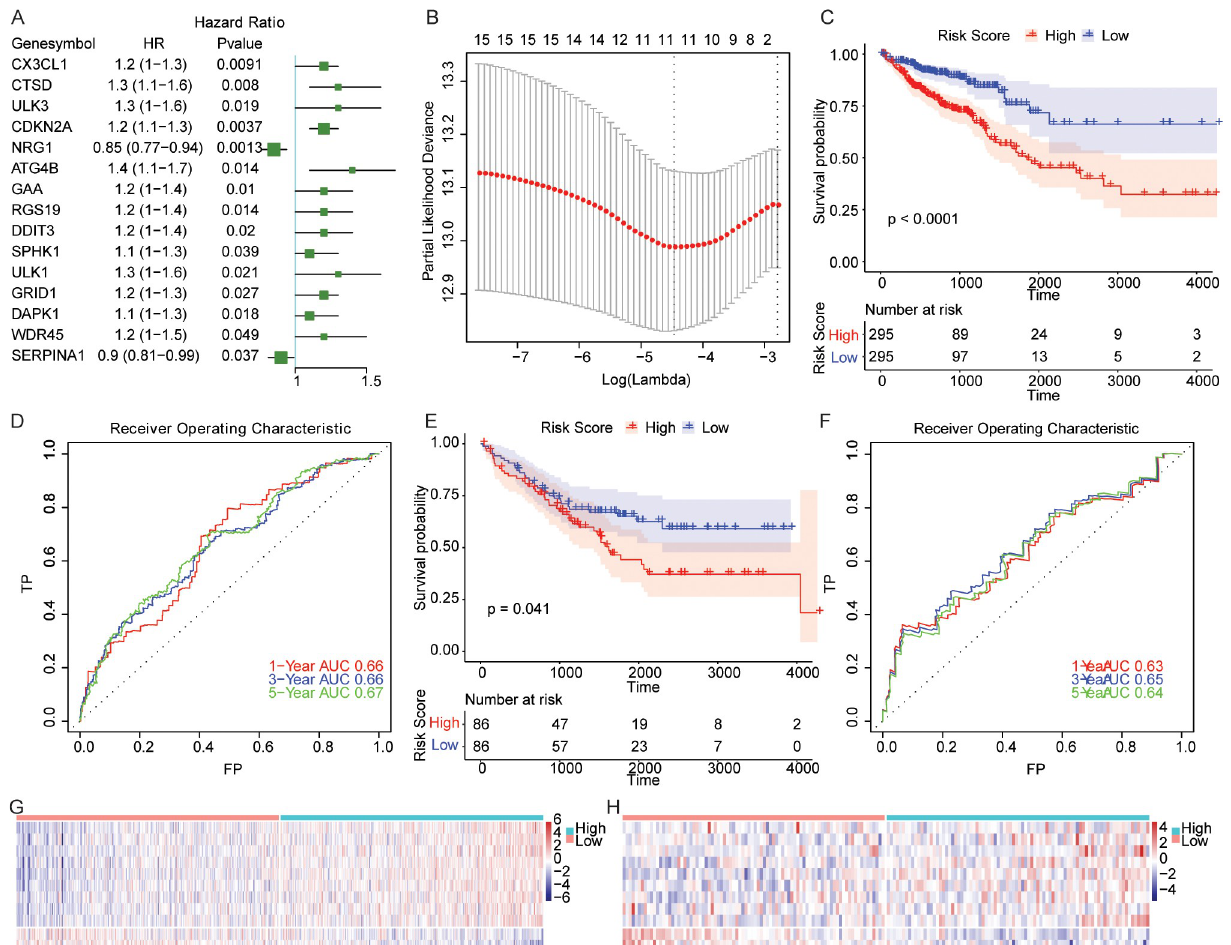
Fig 1. Construction of predictive model for CRC prognosis. (A) Univariate cox regression analysis of the 15 genes that were related to the overall survival (OS) of patients with CRC. HR: hazard ratio. (B) Determination of the lambda value in LASSO regression model. The lambda value which corresponded to the minimum value of Partial Likelihood Deviance was considered as the optimal one. (C) Survival curves of CRC patients in TCGA dataset. P value that calculated using log-rank test was provided. (D) Time-dependent ROC curve for the patients in TCGA dataset. TP: True Positive; FP: False Positive. (E) Survival curve of CRC patients in GEO dataset. (F) Time-dependent ROC curve for the patients in GEO dataset. TP: True Positive; FP: False Positive. (G-H) Heatmaps showing the differential expressions of CX3CL1 , ULK3 , CDKN2A , NRG1 , ATG4B , GAA , RGS19 , DDIT3 , GRID1 , DAPK1 and SERPINA1 of the samples in two groups stratified by risk score from TCGA and GEO respectively. Horizontal and vertical axis represents samples and genes, respectively. Red and blue dot represents higher and lower expressions